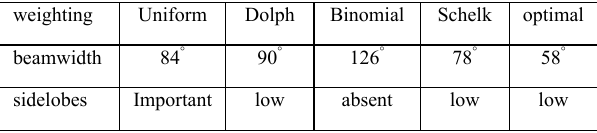
Table 1. Comparison of weighting methods